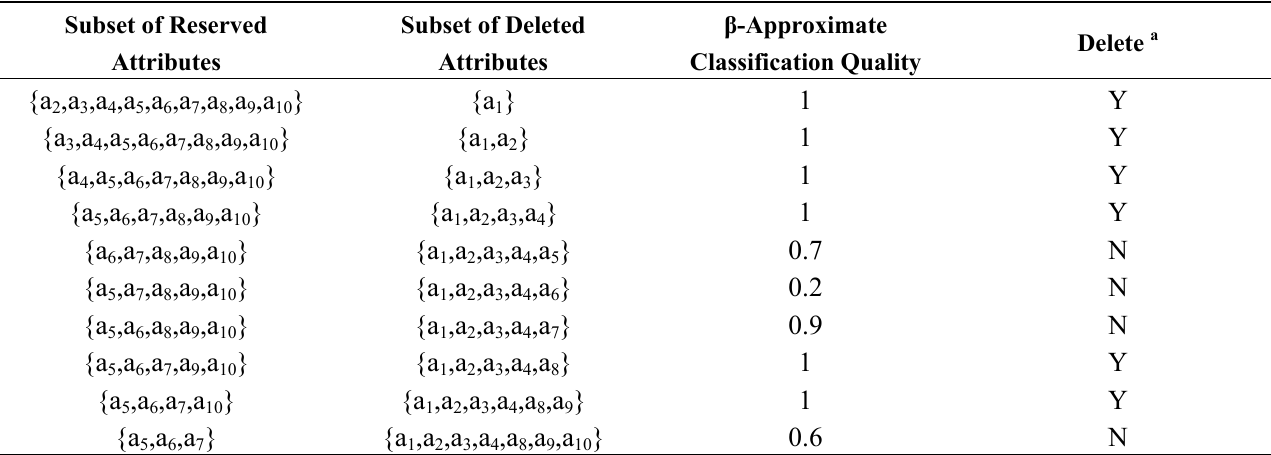
Table 3. Process of FRS attribute